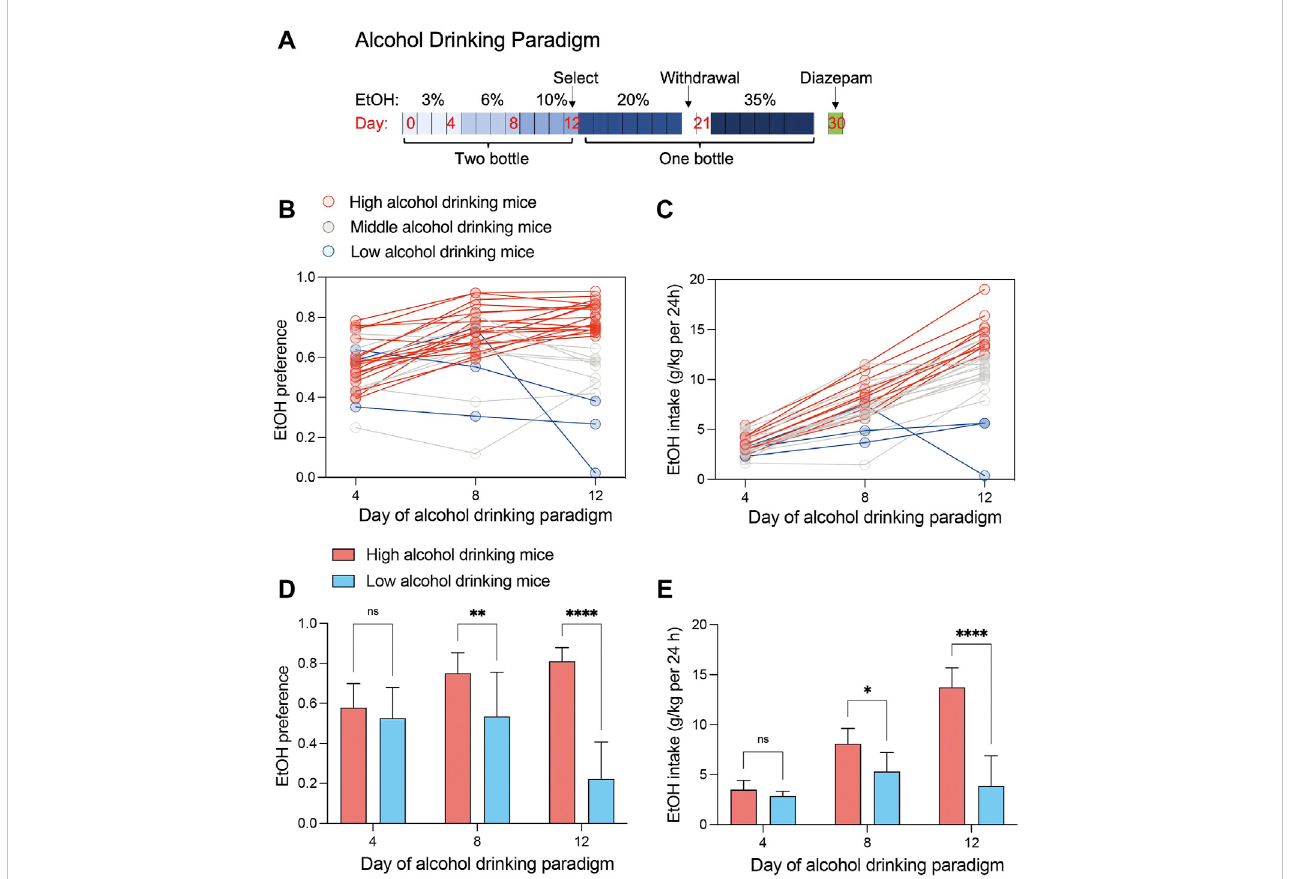
FIGURE 1 Alcohol consumption of C57BL/6J mice (n = 30). (A) A 12-day continuous-access two-bottle choice of alcohol consumption was performed, followed by determination of alcohol consumption behavior. Mice continued to be supplied water or ethanol in one bottle and deprived of ethanol twice (2 days). (B) Individualethanolpreferencescattersmapacrossdayofalcoholdrinkingprocedure.Datashowpreferencefor3%ethanol(day4),6%ethanol(day8),and10% ethanol (day 12). (C) Individual ethanol intake scatters map across day of alcohol drinking procedure. Data show daily intake of 3% ethanol (day 4), 6% ethanol (day 8), and 10% ethanol (day 12). (D) Ethanol preferences in high (n = 19) and low ( n = 3) alcohol consumption groups (two-way ANOVA: interaction effectF(2,60)=15.64, p < .0001;alcoholconsumptiongroupeffectF(1,60)=50.88, p < .0001; Š ídák ’ smultiplecomparisonstest,** p < .01,**** p < .0001). (E) Ethanol intake in high ( n = 19) and low ( n = 3) alcohol consumption groups (two-way ANOVA: interaction effect F (2, 60) = 23.82, p < .0001; drinking